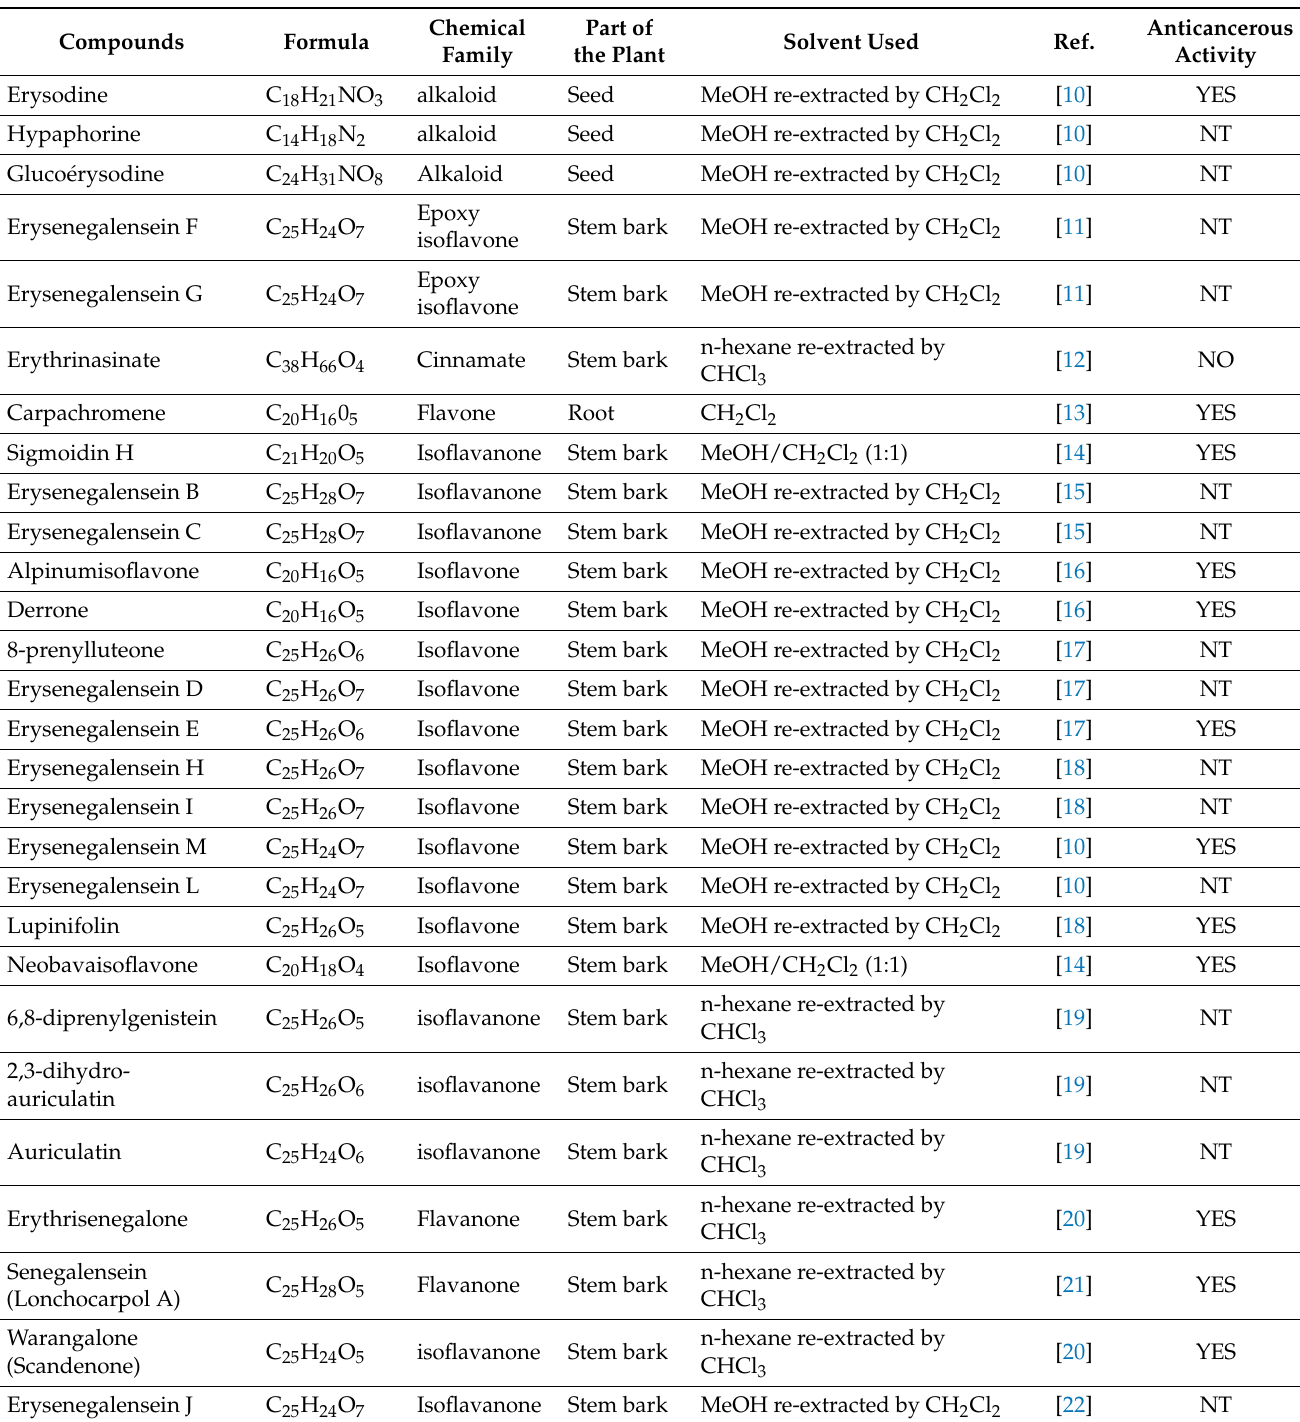
Table 1. Isolated compounds from E. senegalensis described to date with their origin, obtention method and whether their potential anticancerous activities were evaluated; YES: anticancerous activity demonstrated, at least in vitro, NO: tested but no in vitro anticancerous activity observed; NT: not